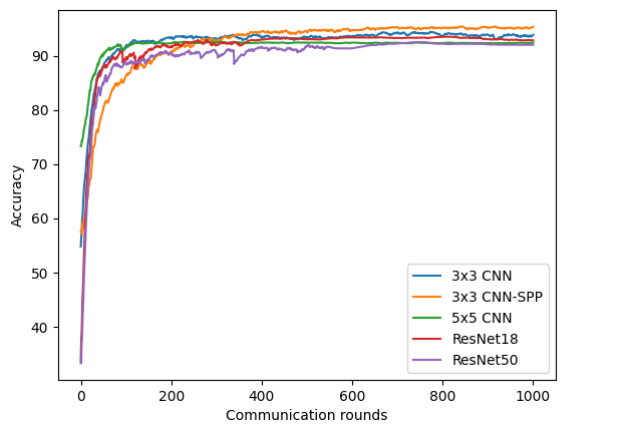
Figure 7. Improvement in COVID-19 detection based on chest X-ray images and 3 × 3